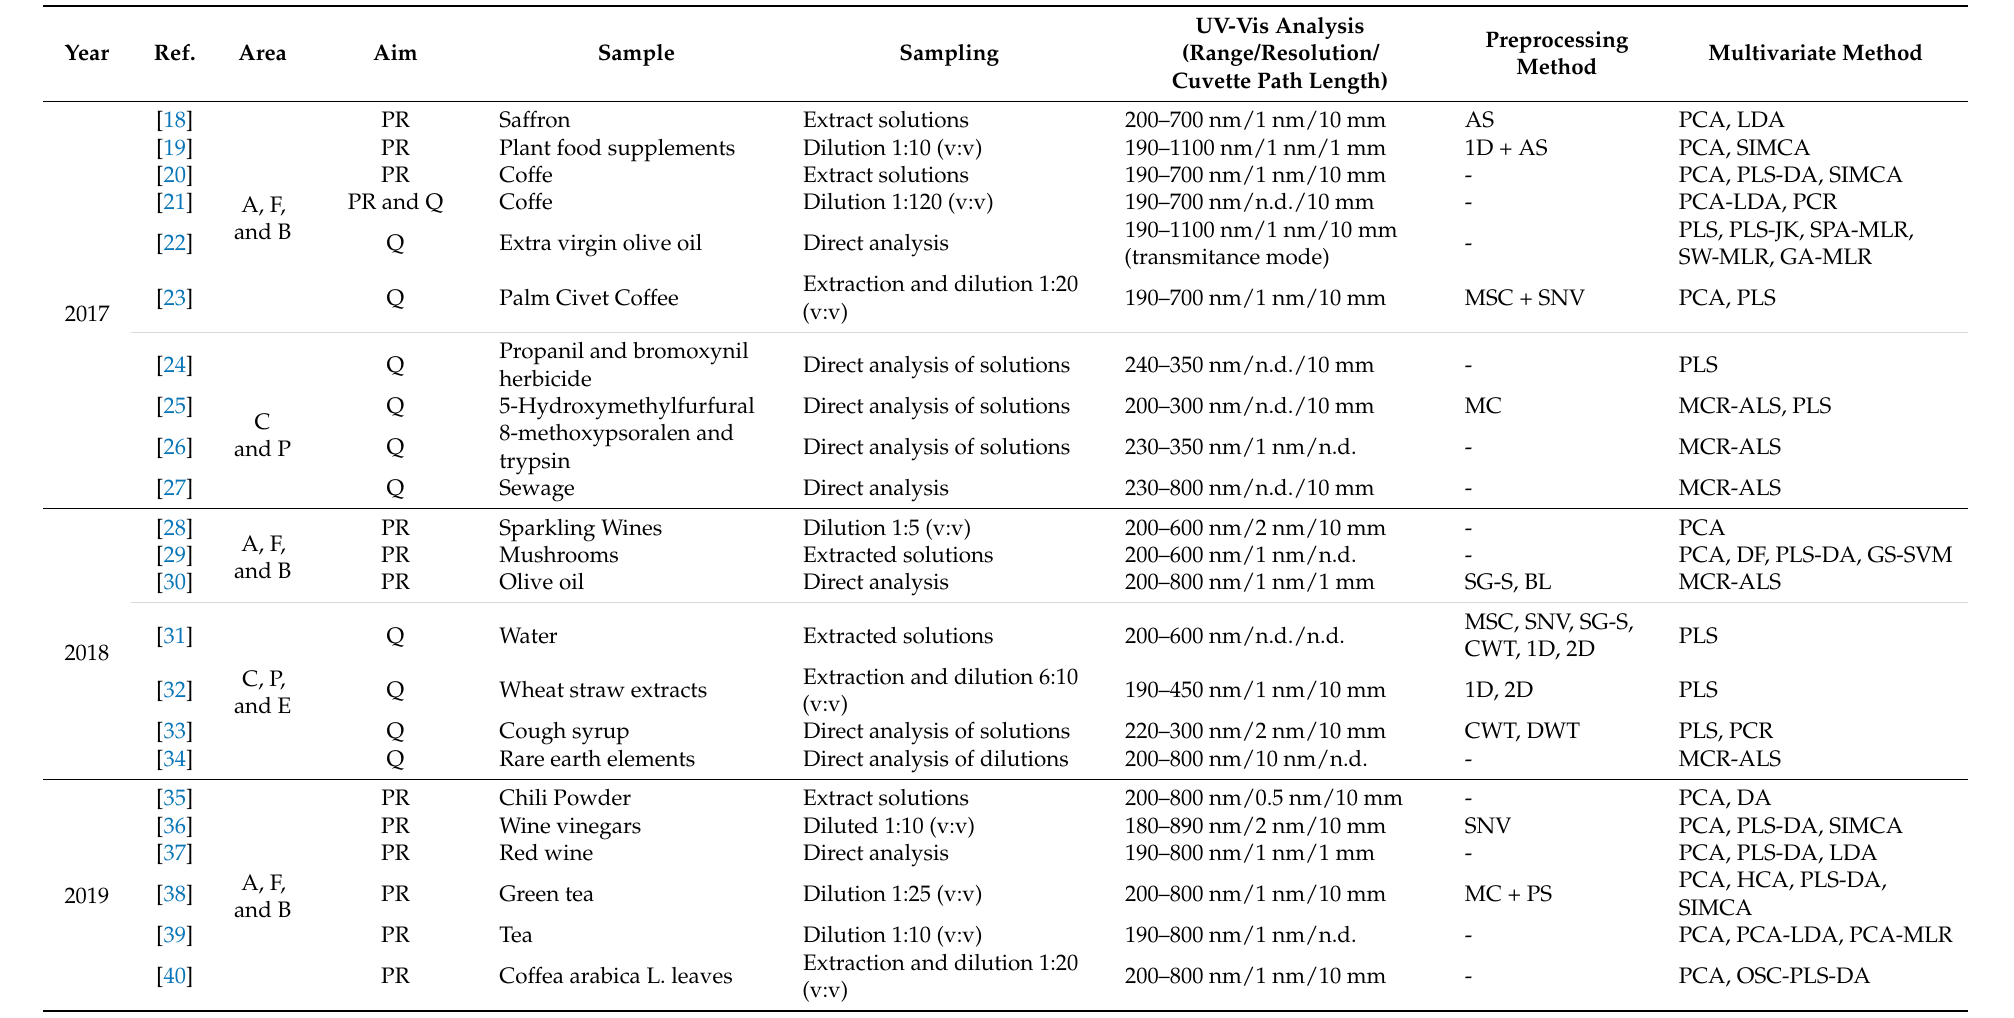
Table 1. Summary of the areas and aims of application and the analytical and chemometric methods used for UV-Vis fingerprinting in the studies published in the last six years